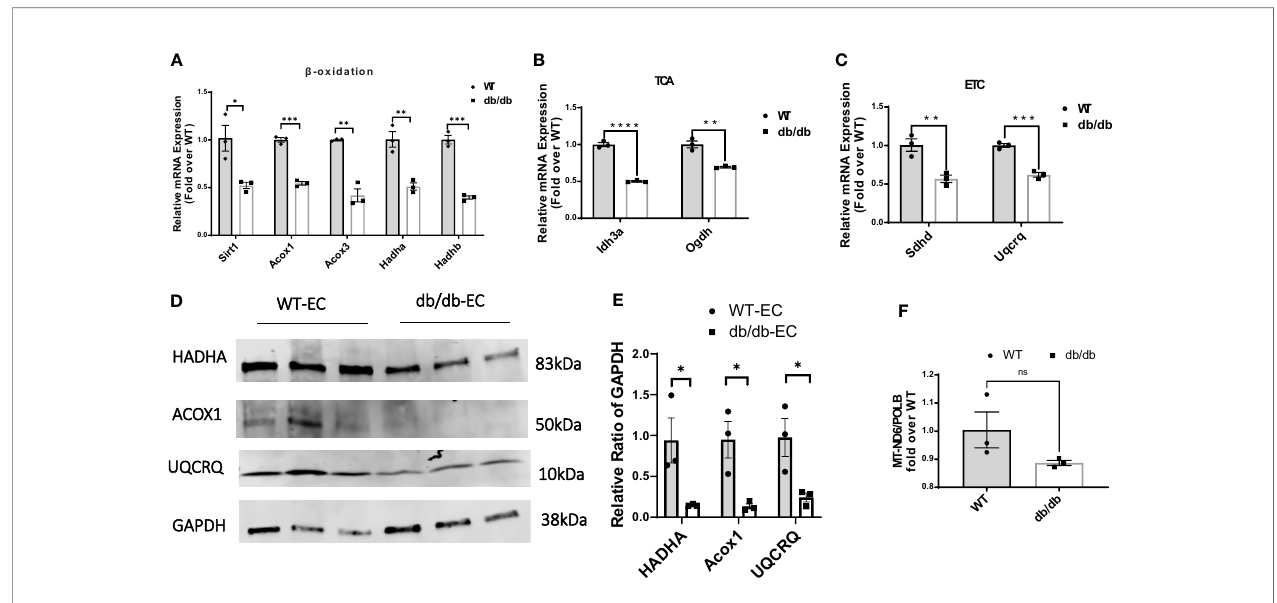
FIGURE 4 | Comparison of relative mRNA levels of genes related to (A) fatty acid b -oxidation (Sirt1, Acox1, Acox3, Hadha and Hadhb), (B) TCA cycle (Idh3a and Ogdh), and (C) ETC (Sdhd and Uqcrq) in WT-CMECs and db/db-CMECs. The amount of mRNA was normalized using b -actin. TCA, tricarboxylic acid cycle; ETC, electron transport chain. Results are shown as mean ± SEM (n = 3), ns p > 0.05, *p < 0.05, **p < 0.01, ***p < 0.001, ****p < 0.0001. (D, E) Comparison of relative protein levels of enzymes related to fatty acid b -oxidation (Hadha and Acox1) and ETC (Uqcrq) in WT CMECs and diabetic CMECs. The amount of protein was normalized using GAPDH. Results are shown as mean ± SEM (n = 3), *P < 0.05. (F) Comparison of the relative copy number of mitochondria (MT)-encoded NADH- ubiquinone oxidoreductase chain 6 (MT-ND6) between WT CMECs and diabetic CMECs. The amount of mitochondrial DNA was normalized to the nuclear-encoded control gene DNA polymerase- b (PolB). Results are shown as mean ± SEM (n = 3), ns p >